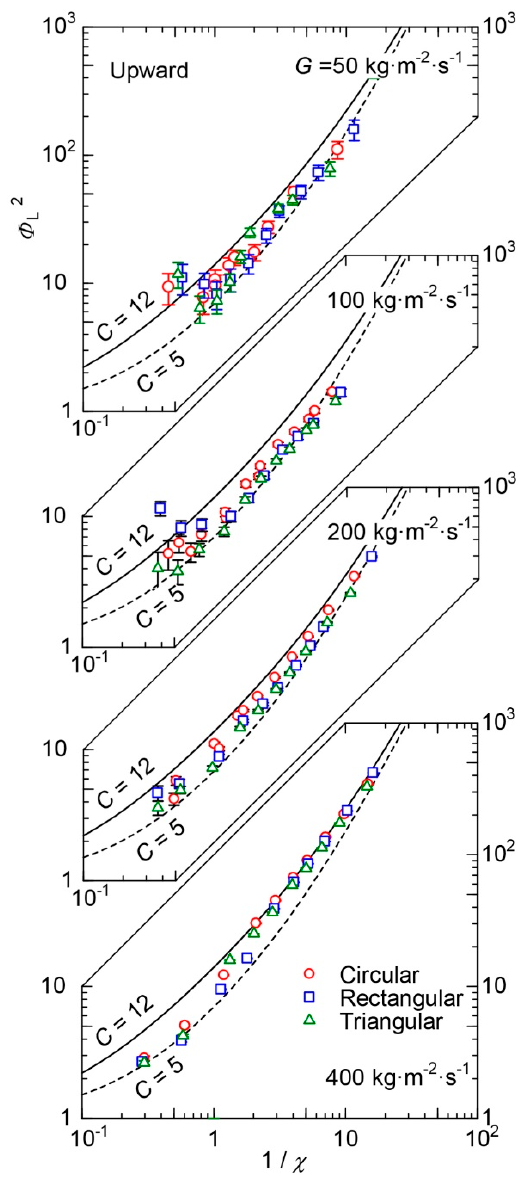
Figure 13. Two-phase frictional multiplier vs. inverse of Lockhart–Martinelli parameter flowing upward in circular, rectangular, and triangular tubes.